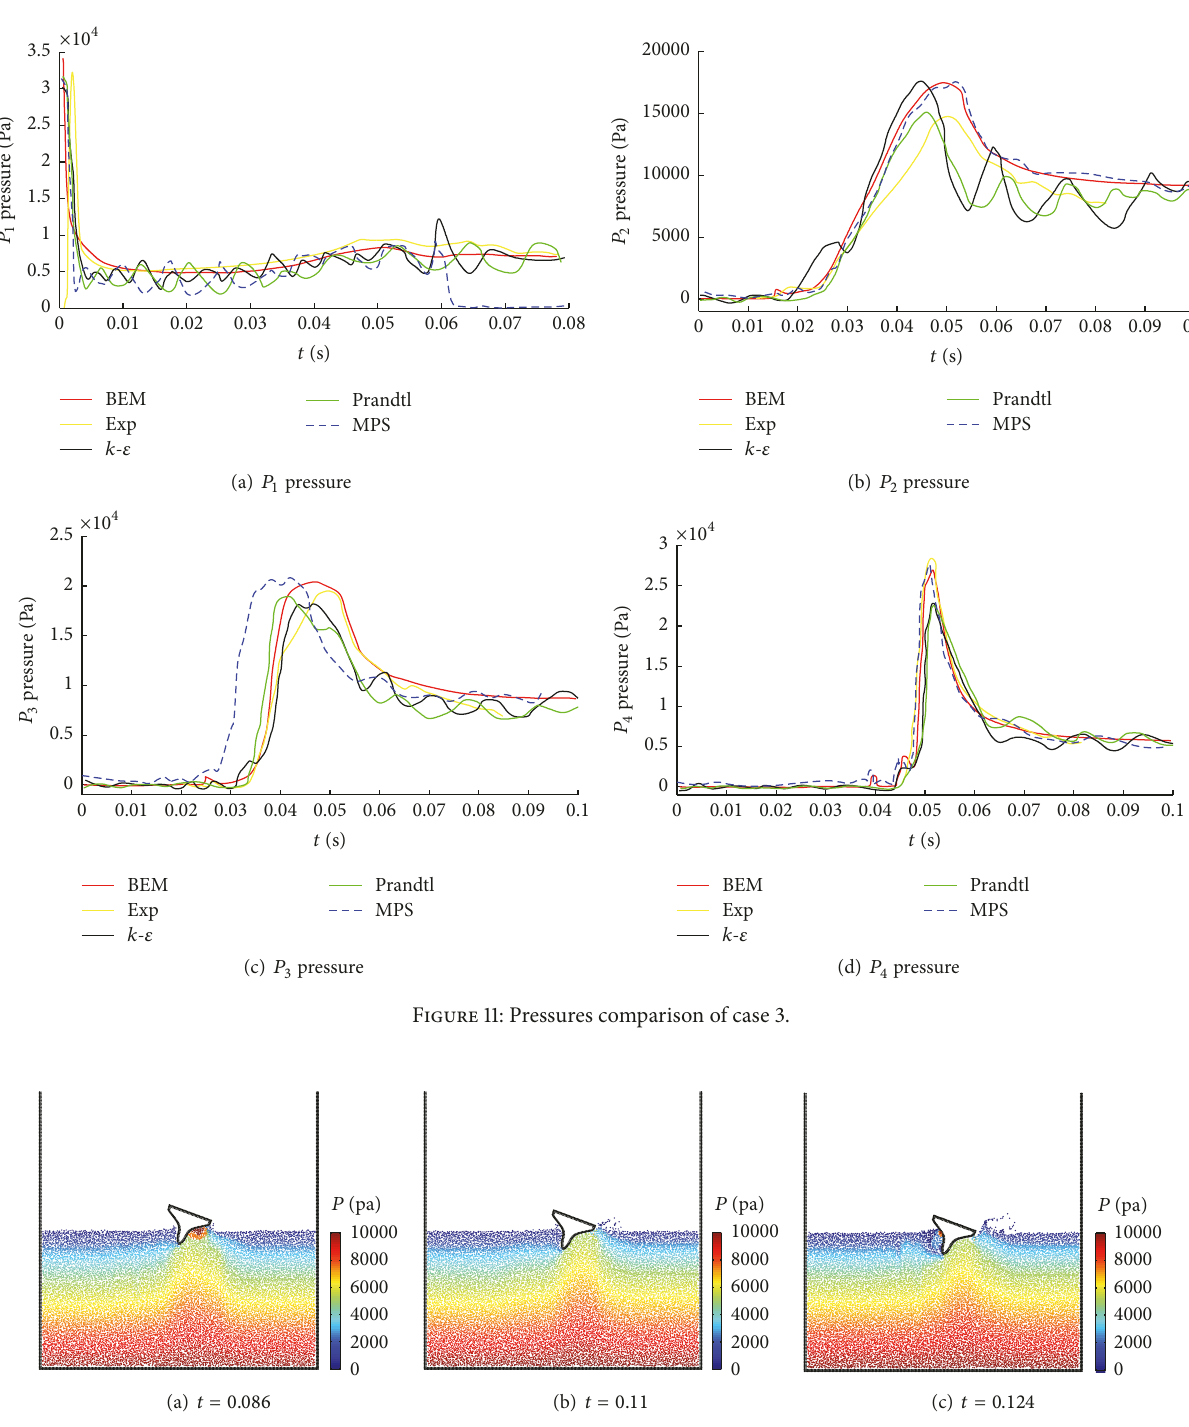
Figure 12: Particles colored by pressure after the impact with entry angle 20.3 ∘ with velocity 0.75 m/s.